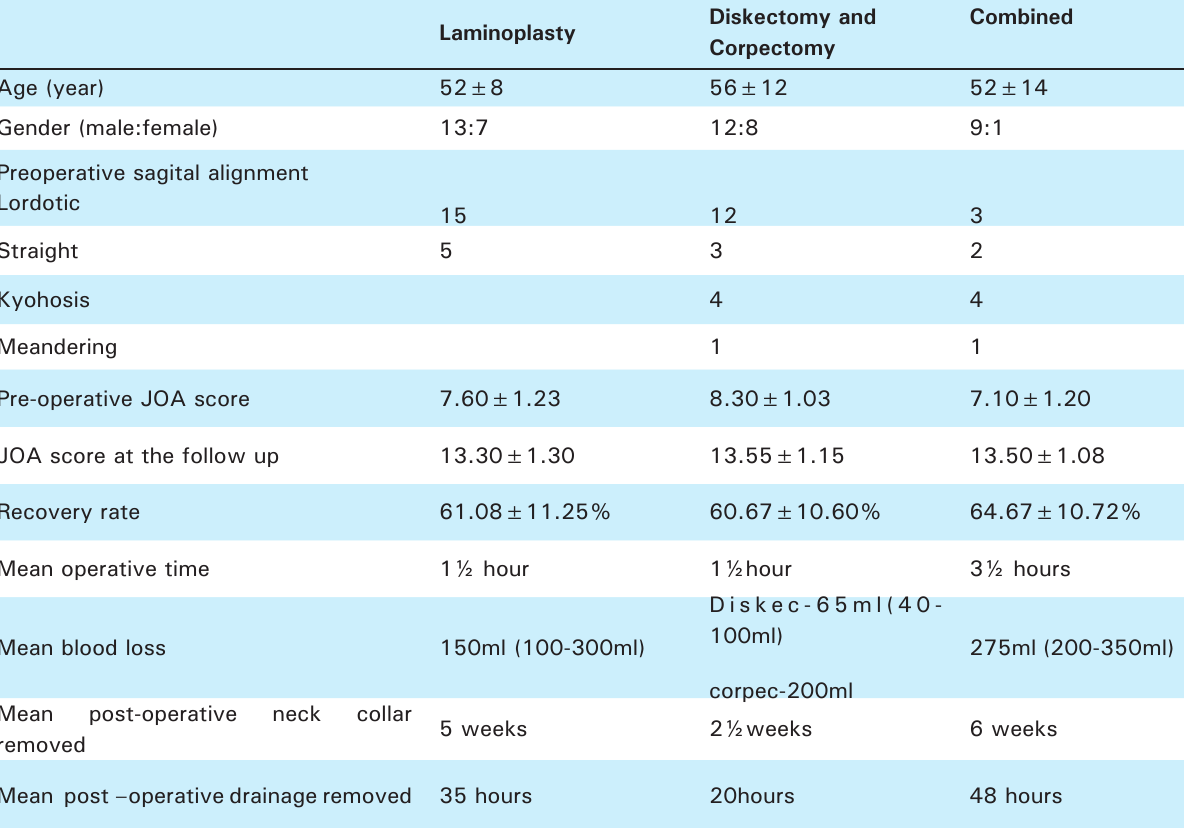
table 1. study puplation’s particulars.